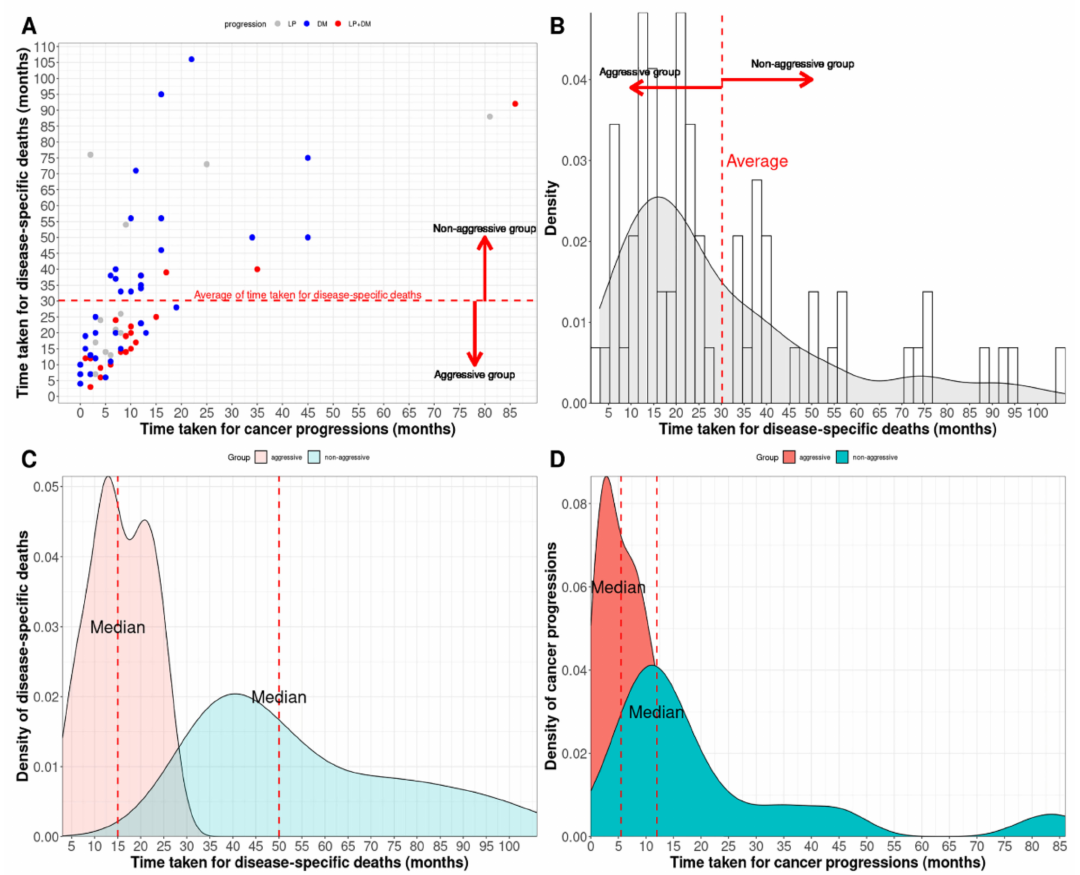
Figure 3. The 69 patients who underwent disease-specific death (DSD) were divided into the aggressive (44 patients) and non-aggressive (25 patients) groups according to the average time taken for DSD. ( A ) Scatterplot between the time to progression and the time to DSD after the end of treatment (local progression (LP)—gray; distant metastasis (DM)—blue; LP + DM—red) and ( B ) density plot and histogram of the time 69 patients underwent DSD. Density plots between the aggressive and non-aggressive groups for ( C ) DSD and ( D ) cancer progression,